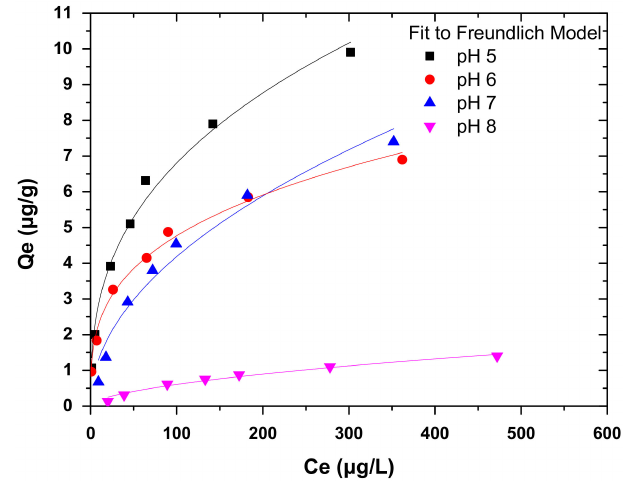
Figure 8. Freundlich isotherms for the adsorption of Cr(VI) on COC-AC-La; initial Cr(VI) concen- tration 30–500 µ g/L, solution pH 5–8, adsorbent’s dose 0.2 g/L, T = 22 ± 1 ◦ C, contact time 24 h, in deionized